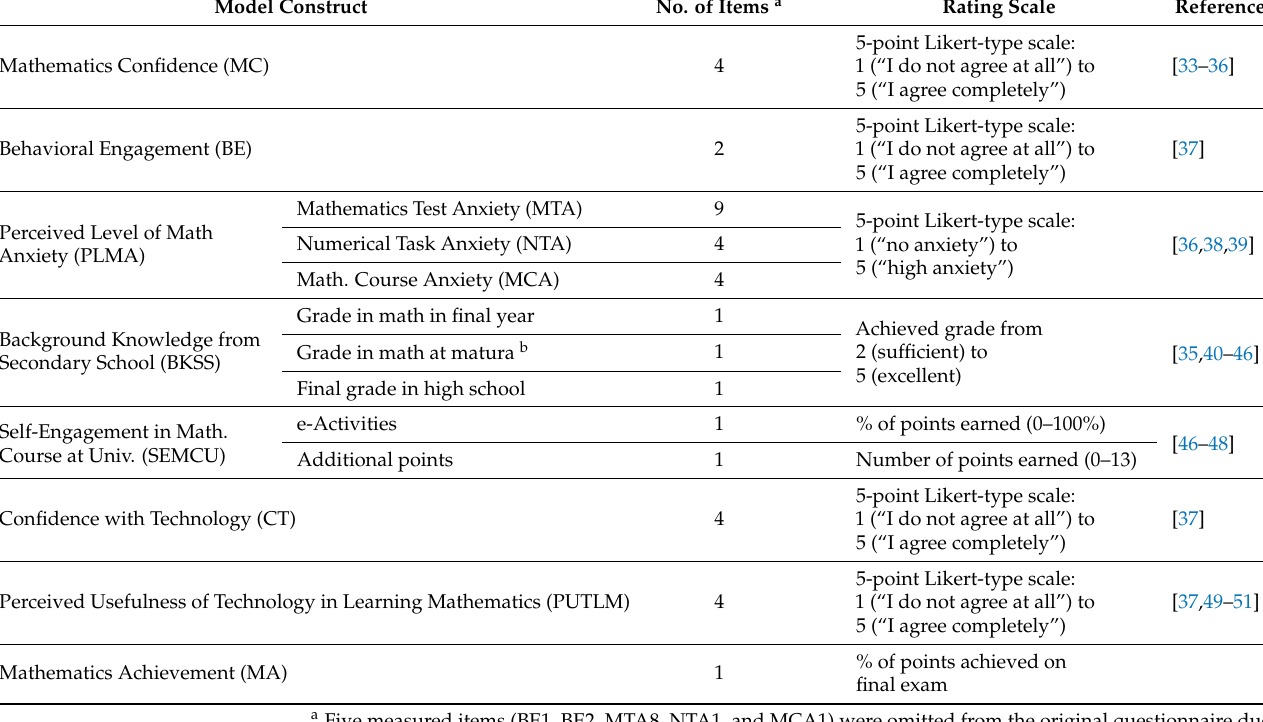
Table 1. Constructs of conceptual model developed in [19]: pre-pandemic approach.